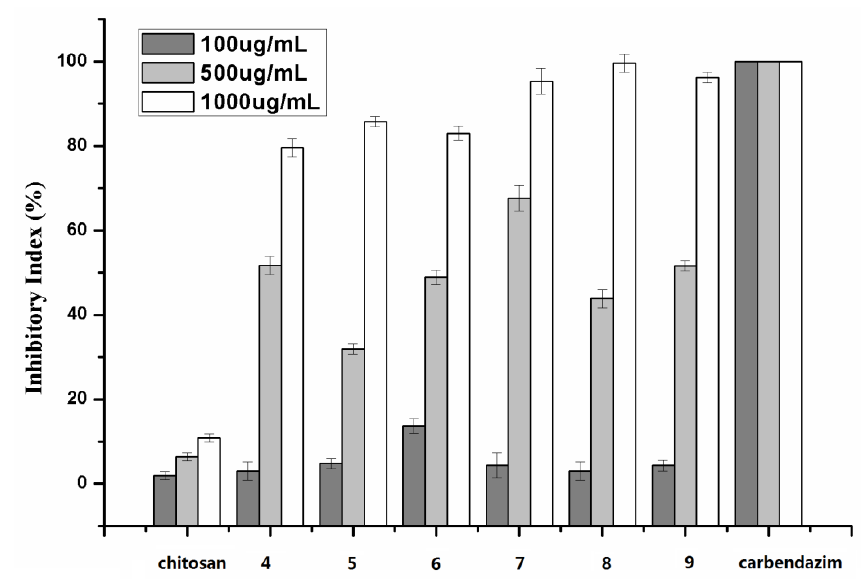
Figure 4. The antifungal activity of chitosan and chitosan derivatives against Watermelon fusarium .